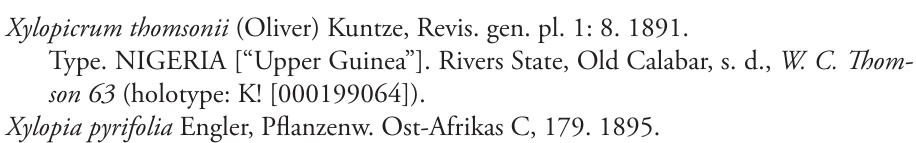
Fig. 39A–C Xylopicrum thomsonii (Oliver) Kuntze, Revis. gen. pl. 1: 8. 1891. Type. NIGERIA [“Upper Guinea”]. Rivers State, Old Calabar, s. d., W. C. Thom- son 63 (holotype: K! [000199064]). Xylopia pyrifolia Engler, Pflanzenw. Ost-Afrikas C, 179.